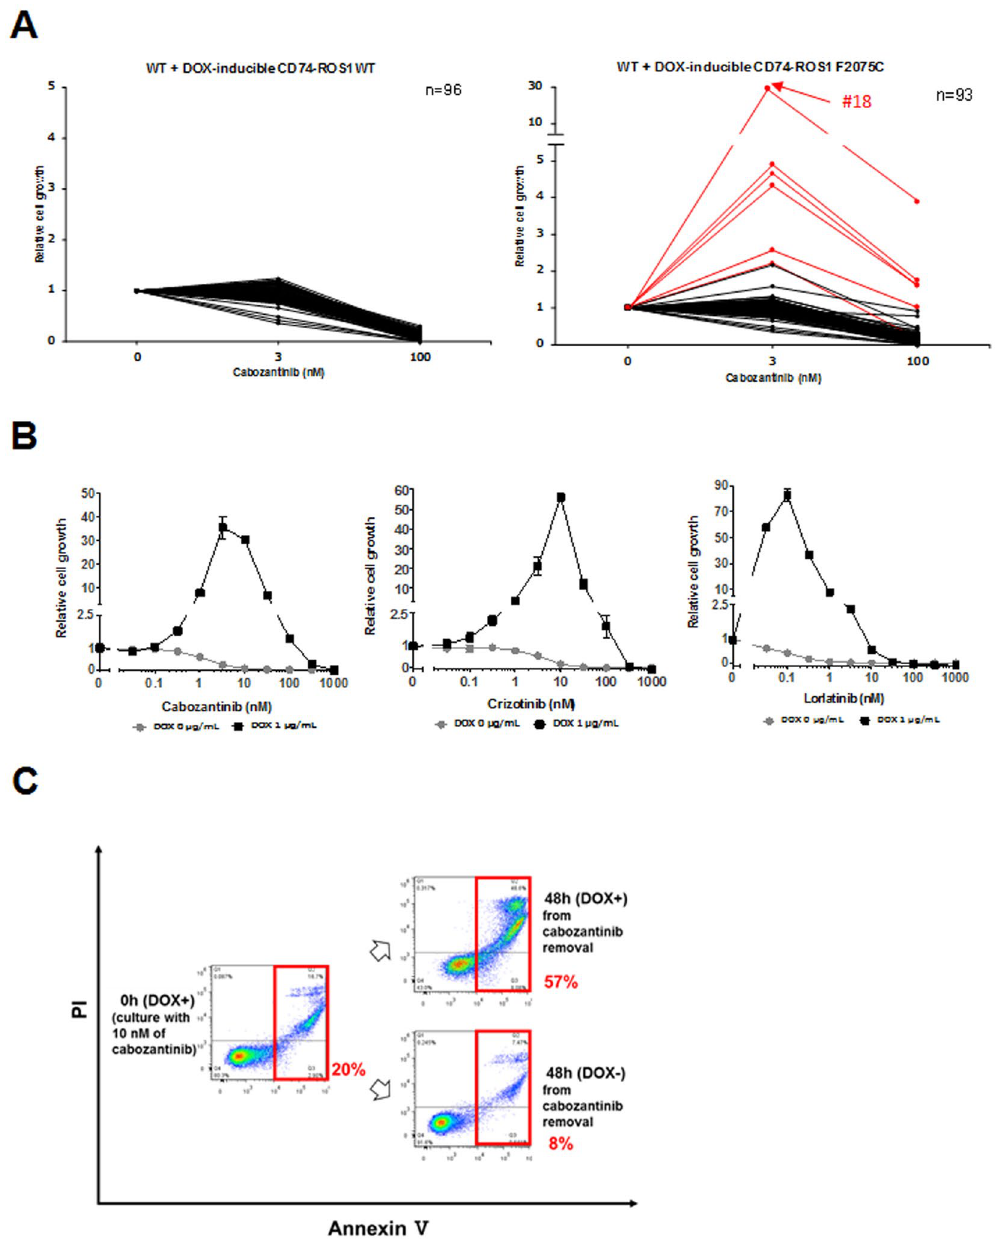
Figure 4. Reconstructed Ba/F3 cells conditionally over-expressing F2075C-mutated CD74-ROS1 show characteristics of ROS1-TKI addiction. ( A ) Viability of wild-type CD74-ROS1 cell clones expressing doxycycline (DOX)-inducible CD74-ROS1 wild-type (left) or F2075C (right). Each clone was untreated (0) or treated with 3 or 10 nM cabozantinib in addition to 1 μ g/mL of DOX for 72 hours, and cell viability was measured with the CellTiter-Glo assay. Each value is shown as relative cell growth by normalizing with the value of untreated wells. The top 6 clones with enhanced proliferation under treatment with 3 nM of cabozantinib compared with untreated cells are shown in red. ( B ) Sensitivity to cabozantinib (left), crizotinib (middle) or lorlatinib (right) of wild-type CD74-ROS1 cells expressing DOX-inducible CD74-ROS1 F2075C, clone #18 (reconstructed F2075C). Each reconstructed F2075C cell line with or without 1 μ g/mL of DOX was treated with the indicated dose range of inhibitors for 72 h, then cell viability was measured by the CellTiter-Glo assay. Each value is shown as relative cell growth by normalizing to the value of untreated wells. ( C ) Apoptosis assay by flow cytometry for reconstructed F2075C cells incubated with 10 nM cabozantinib and 1 μ g/mL DOX for 7 d, then removal of cabozantinib in the presence or absence of 1 μ g/mL DOX for 48 h. The percentage of cells undergoing apoptosis is shown in